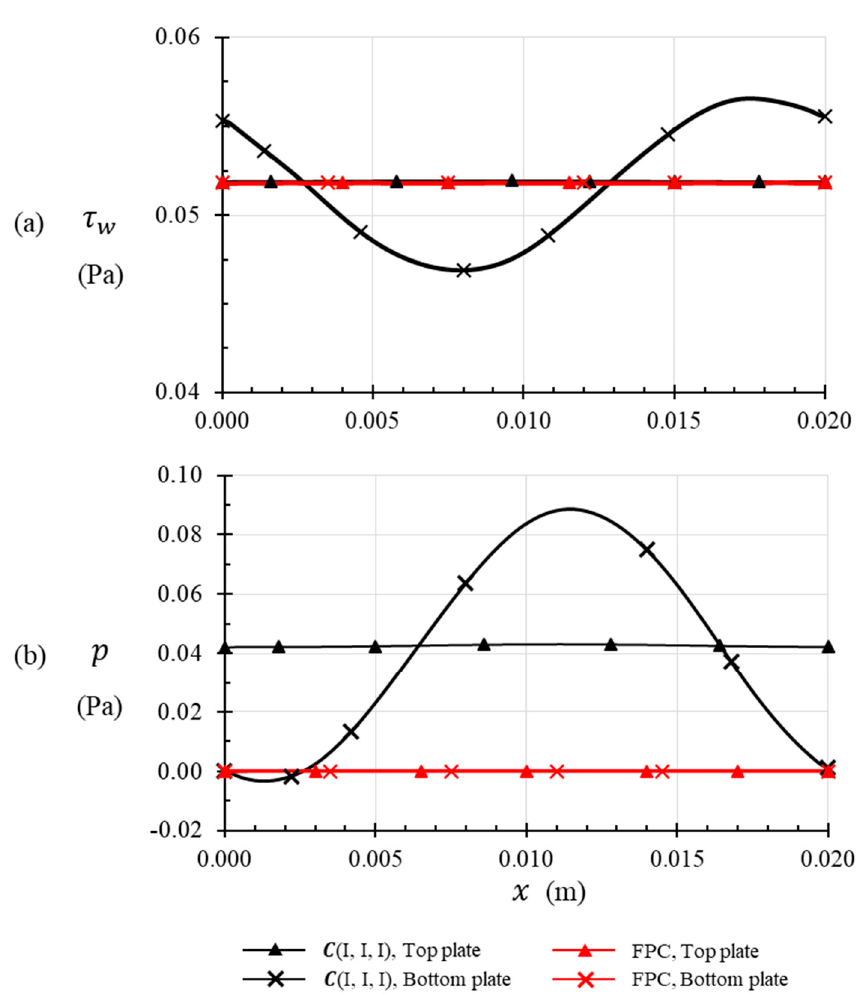
Figure 7. Comparison of 𝑪 (I, I, I) and FPC with respect to; ( a ) wall shear stress; and ( b ) pressure on